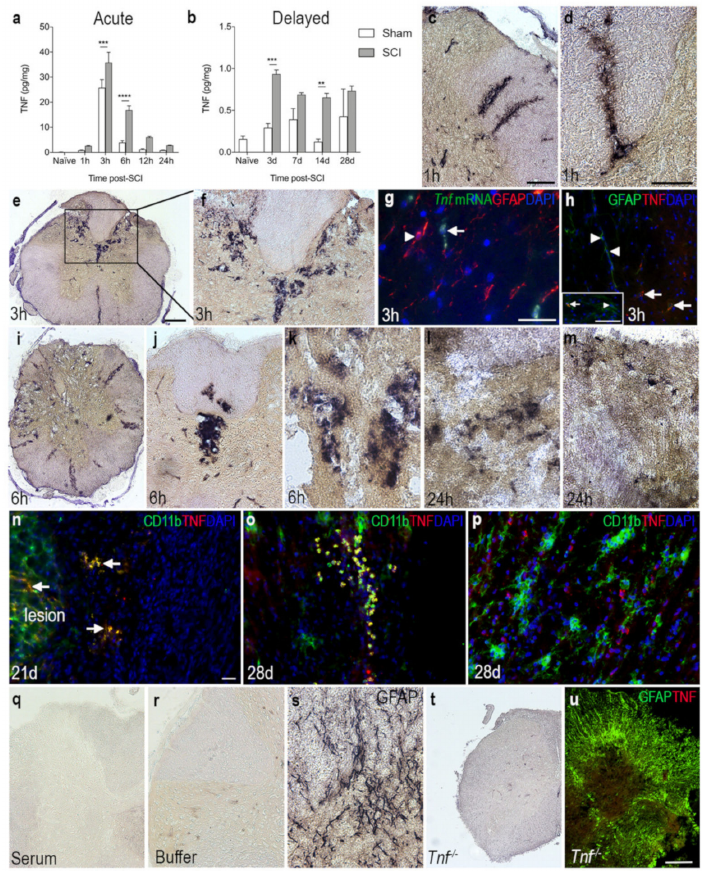
Figure 3. Overview of the spatiotemporal expression of TNF after SCI. ( a , b ) Temporal expression of TNF levels in the acute ( a ) and delayed ( b ) phase after SCI. Statistical indications represent comparisons to sham mice in the acute phase (SCI: p < 0.0001, F 1,48 = 31.7; Time: p < 0.0001, F 5,48 = 105.4; Interaction: p = 0.0008, F 5,48 = 5.08) and delayed phase (Interaction: F 4,39 = 3.05, p = 0.03; Time: F 4,39 = 5.22, p = 0.002; SCI: F 1,39 = 30.74, p < 0.0001) after SCI. Results are expressed as mean ± SEM, n = 5/group, ** p < 0.01, *** p < 0.001, **** p < 0.0001. ( c , d ) Representative images of TNF immunoreactivity in grey matter of the dorsal horn and the lateral funiculus ( c ), as well as the posterior funiculus ( d ) of mice that survived 1 h after SCI. ( e , f ) At 3 h, TNF immunoreactivity was high in the dorsal parts of the lesioned spinal cord. ( g ) Combined in situ hybridization for Tnf mRNA (green, arrow) and immunohistochemistry for astroglial GFAP (red, arrowhead) 3 h after SCI. ( h ) Double immunofluorescent staining for astroglial GFAP (green, arrow heads) and TNF (red, arrows) 3 h after SCI. Insert demonstrates that a minority of GFAP + cells (green, arrowhead) co-expressed TNF (red, arrow). ( i – m ) Representative images of TNF immunoreactivity 6 h ( i – k ) and 24 h ( l , m ) after SCI. ( n ) Double immunofluorescent staining for TNF (red, arrow) and the microglial/macrophage marker CD11b (green) showed colocalization of TNF on CD11b + cells near the lesion 21 days after SCI. ( o ) Double immunofluorescent staining for TNF (red) and the CD11b (green) showed colocalization of TNF on CD11b + cells located at the peri-lesion area 28 days after SCI. DAPI (blue) was used as a nuclear marker. ( p ) TNF was also found in CD11b − cells 28 days after SCI. ( q , r ) Control reactions demonstrating absence of specific staining in tissue sections incubated with rabbit IgG ( q ) or with buffer alone ( r ). ( s ) Spinal cord section stained for astrocytic GFAP as a control for the immunohistochemical reaction. ( t , u ) Thoracic spinal cord tissue sections from a Tnf − / − mouse 3 h after SCI, demonstrating absence of specific TNF staining. Scale bars: ( c , f , j , q) = 40 µ m, ( e , i , t , u , o ) = 100 µ m, and ( d , g , h , k , l – n , p , r , s ) = 200 µ m. CD, cluster of differentiation; GFAP, glial fibrillary acidic protein; TNF, tumor necrosis